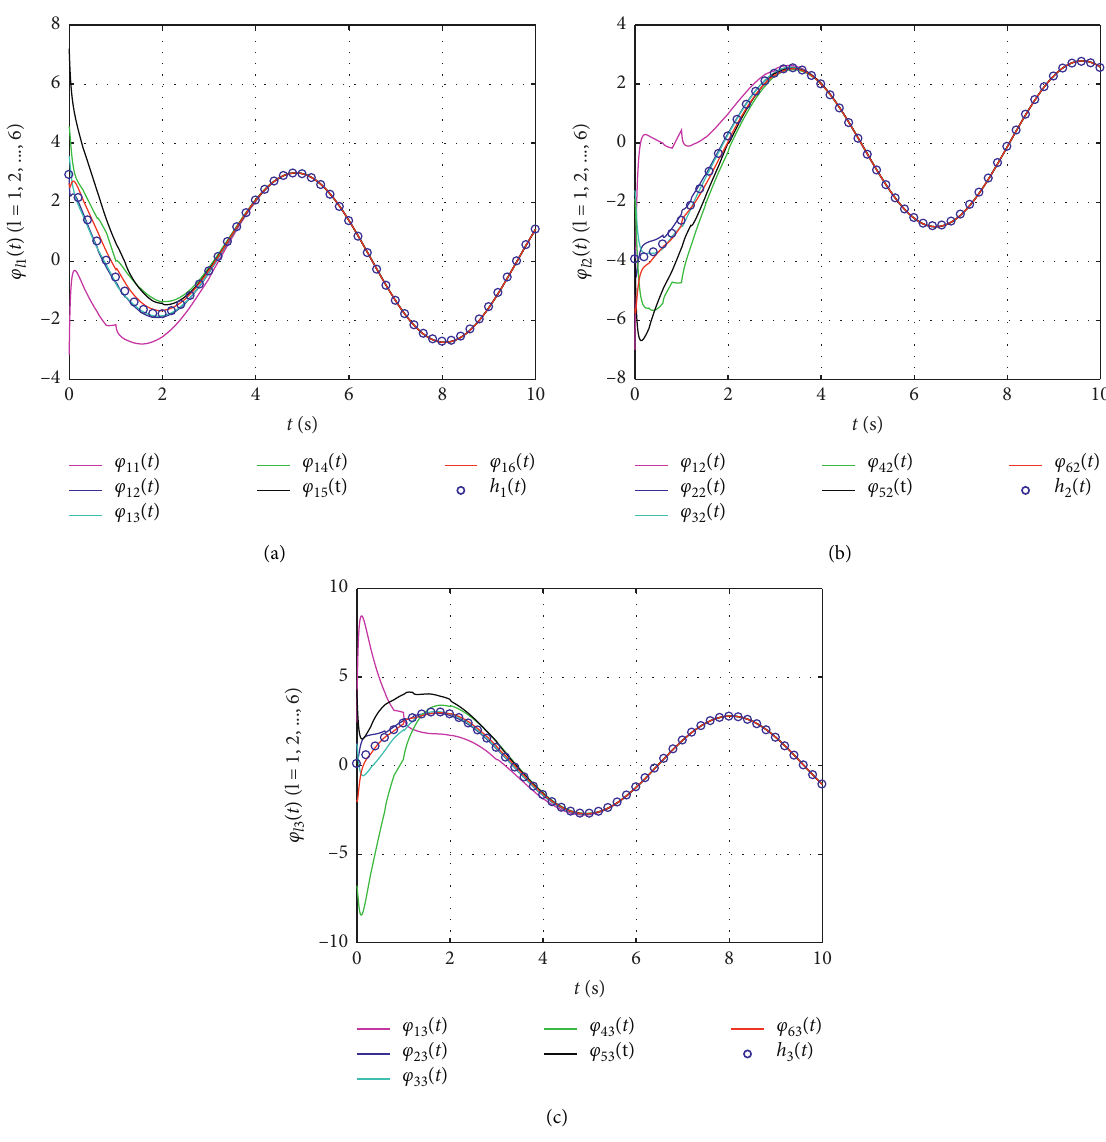
Figure 2: Trajectories of φ